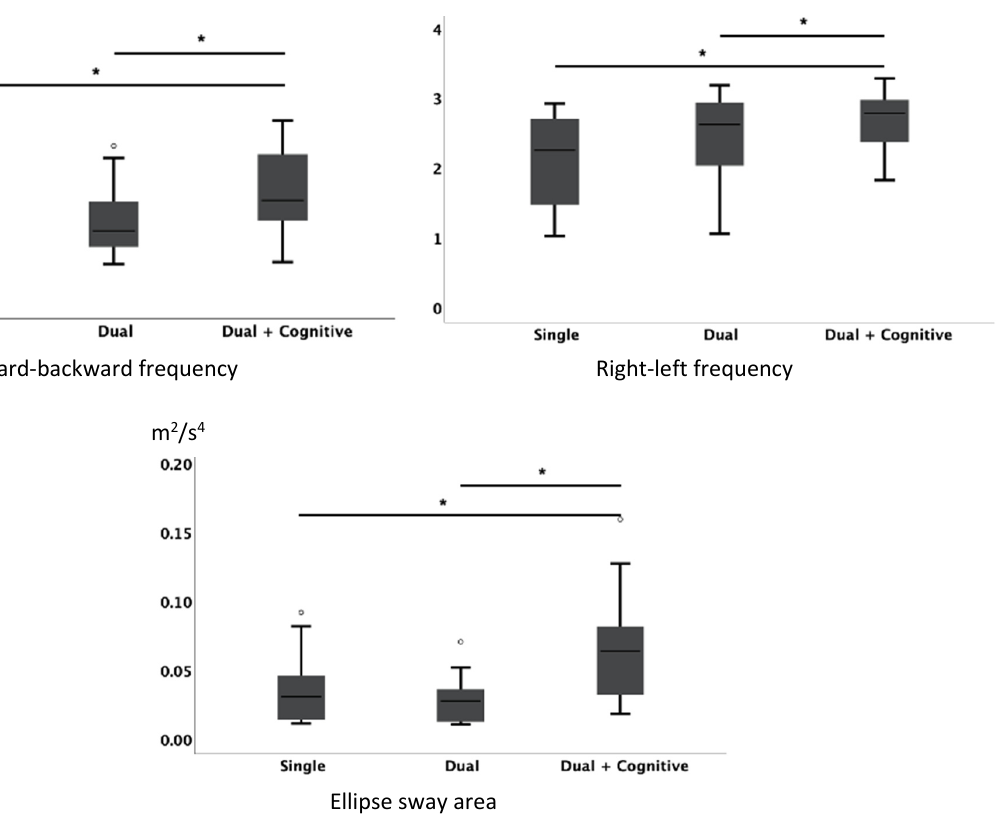
Figure 2. Balance parameters for the three conditions: single task, dual task, and dual and cognitive task during the ISWAY test. * Significant differences for pairwise